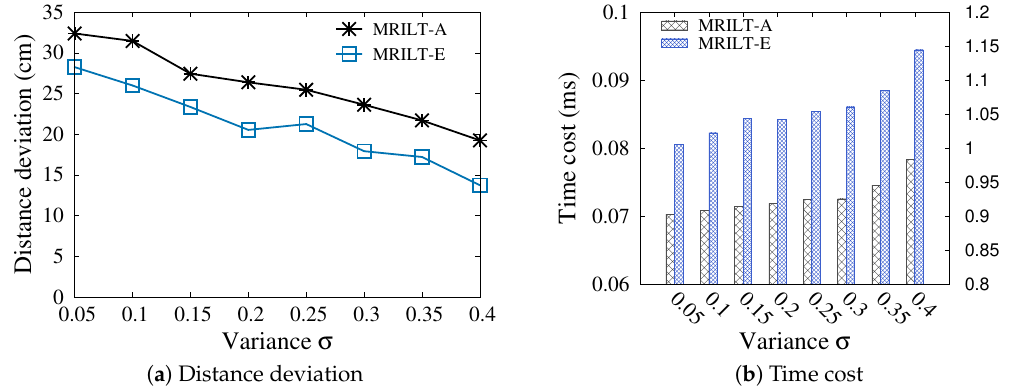
Figure 6. Varying σ with δ d = 20 cm, δ s = 3, grid _ size = 60